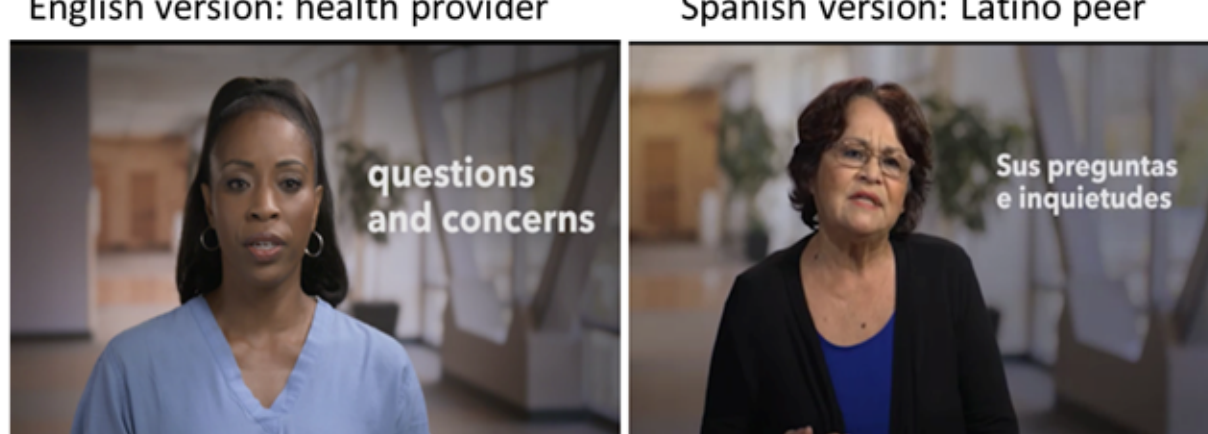
Figure 2. Actors in the Spanish version were switched with a